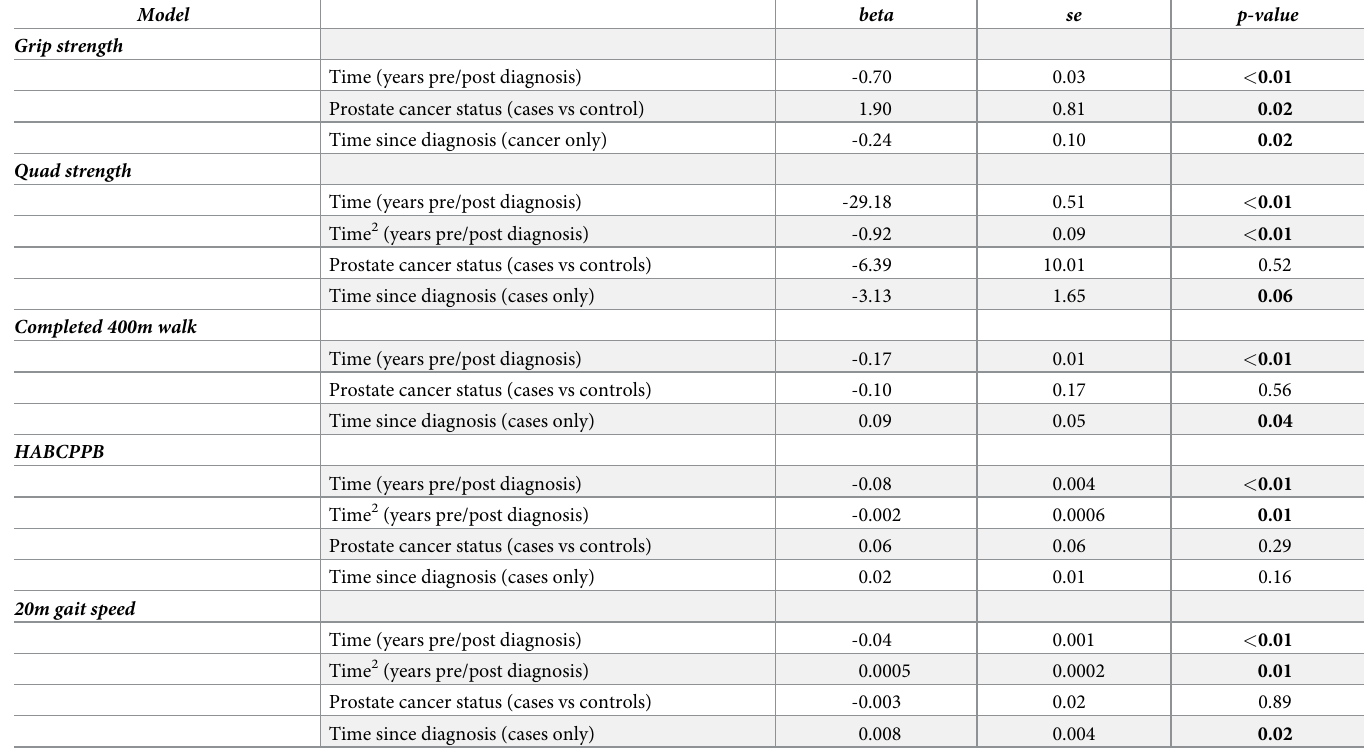
Table 2. Repeated measures mixed-effects regression models of change in physical function by prostate cancer